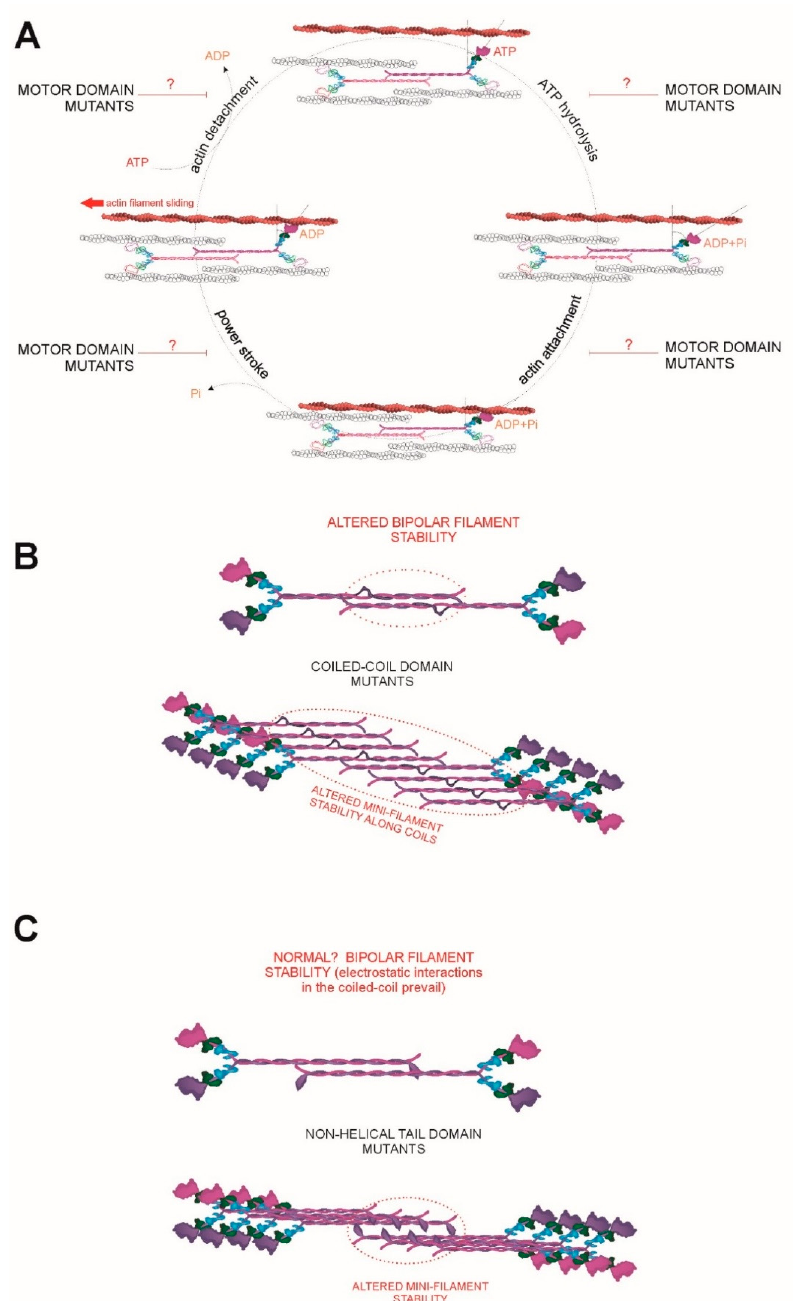
Figure 3. ( A ) Schematic representation of the cross-swinging cycle [93], and the possible e ff ects of diverse motor mutants found in MYH9-RD patients. The mutations can a ff ect ATP hydrolysis (top right), actin binding (bottom right), phosphate release (bottom left) and / or nucleotide exchange and / or actin detachment (top left). ( B ) Possible e ff ects of mutations in the coiled coil domain (represented as a bulge in the center of the coil). Depending on the precise site and type of mutation, the formation of the initial bipolar mini-filament (top) may be impaired, or enhanced. The same argument applies to their growth into mini-filaments (bottom). ( C ) Possible e ff ects of mutations in the NHT domain (represented as a bulked-up tail). It is unlikely that bipolar filament formation (top) is largely a ff ected as electrostatic interactions between coiled coils dominate this step [73,74]. Color codes of the di ff erent chains is as in Figure